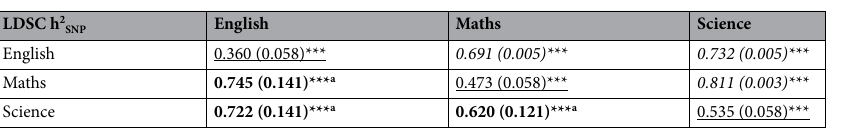
Table 3. SNP-based heritability estimates, and genetic and phenotypic correlations between academic subjects. Genetic correlations are presented below the diagonal (bold), SNP-based heritability on the diagonal (underline) and phenotypic correlations above the diagonal (italics). Standard errors are in parentheses. Due to the genetically homogenous nature of this sample LDSC SNP heritability and genetic correlation estimates are reported with the h 2 intercept constrained to 1. Unconstrained LDSC estimates are provided in Supplementary Table S7. Phenotypically, science is significantly more correlated with English (z = 5.80, p = 3.35 × 10 –9 ) and maths (z = 20.58, p = 2.08 × 10 –94 ) than these were with each other. There are no significant differences in the genetic correlations between subjects (p’s > 0.05). ***p ≤ 0.001. a These correlations were significantly less than